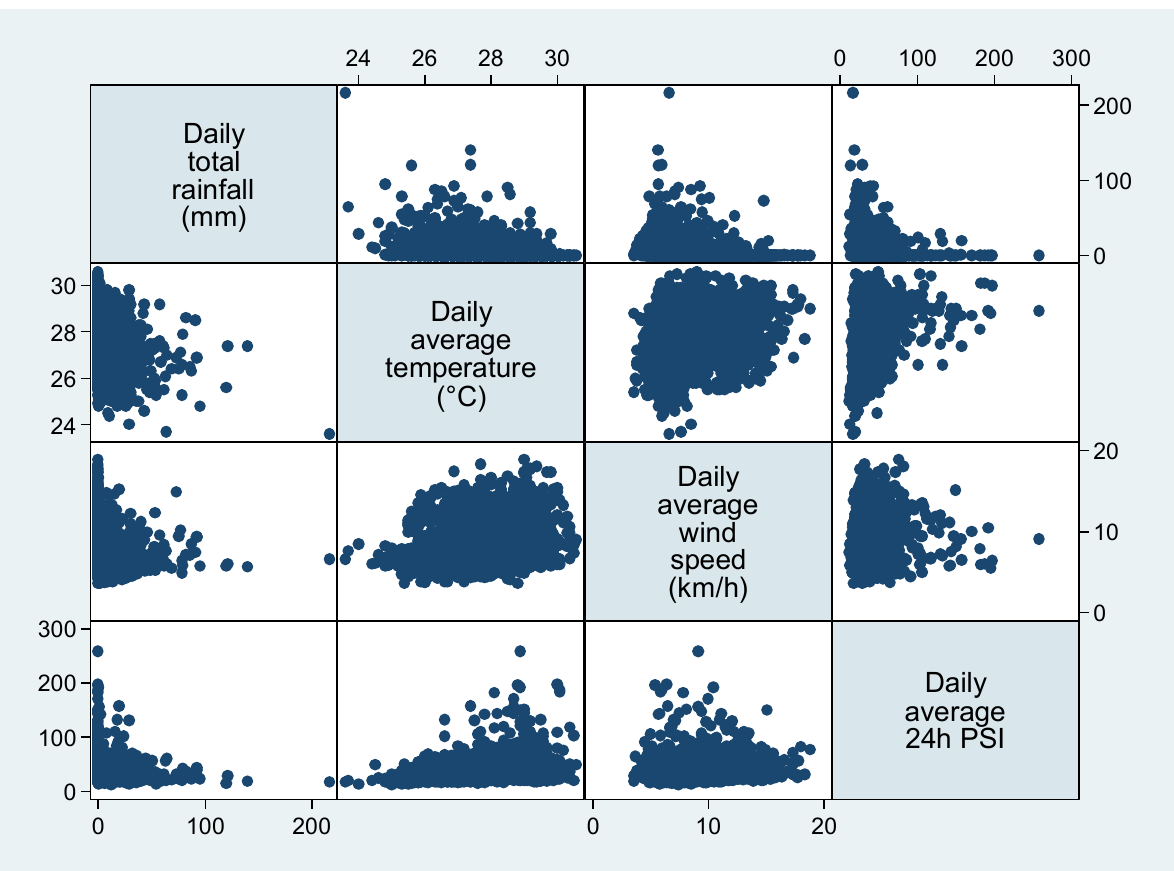
Figure 1. Scatterplots showing the association between the weather and air quality (N = 2191 days).